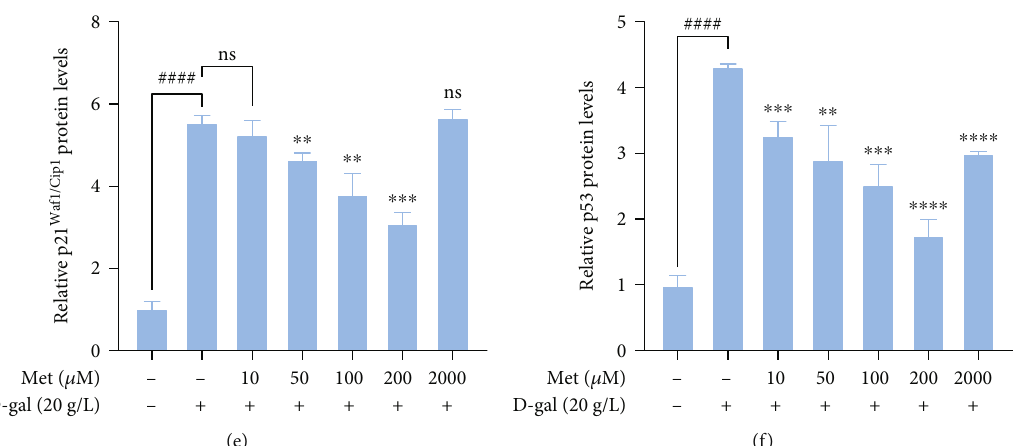
Figure 3: The e ff ect of metformin on reversing cell cycle arrest in D-gal-induced hBMSCs. (a) Analysis of cell cycle distribution by fl ow cytometry. (b) Bar graph of cell cycle distribution. (c – f) The expressions of p16 INK4a , p21 Waf1/Cip1 , and p53 proteins were detected by western blot analysis. GAPDH was used as a control. n = 3 for each group. Data shown are mean ± SEM . Two-tailed t test. ∗ p < 0 : 05 , ∗∗ p < 0 : 01 , ∗∗∗ p < 0 : 001 , and ∗∗∗∗ p < 0 : 0001 versus the D-gal group; ### p < 0 : 001 and #### p < 0 : 0001 versus the control group; ns: not signi fi Figure S2). SA- β -Gal staining, as a widely used method for cell